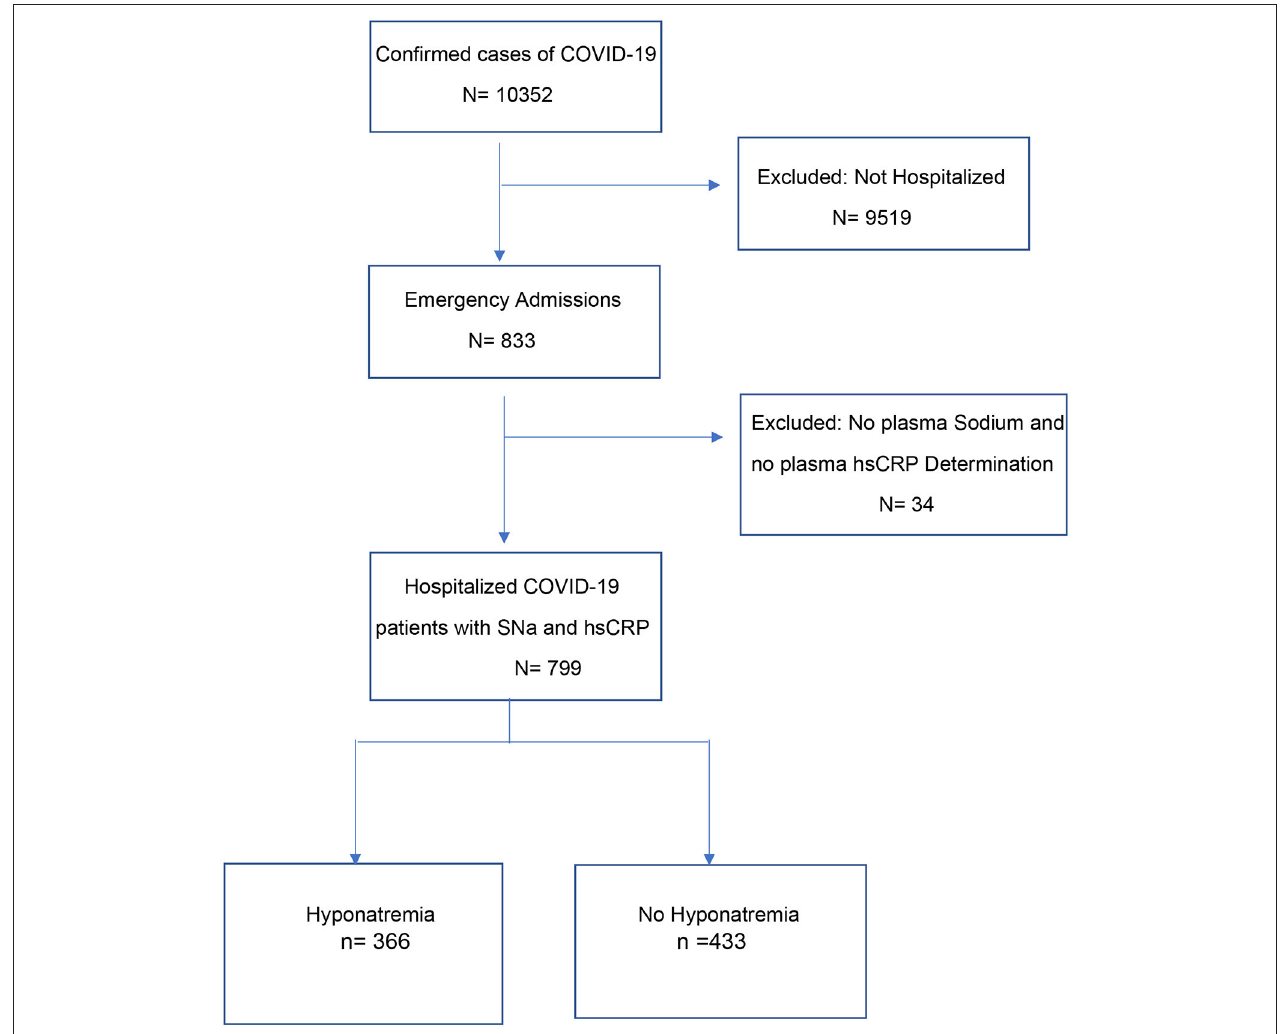
FIGURE 1 | Cohort assembly of eligible patients hospitalized for